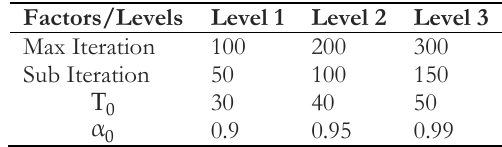
Table 2. The different factors and levels of the of the SA parameters.